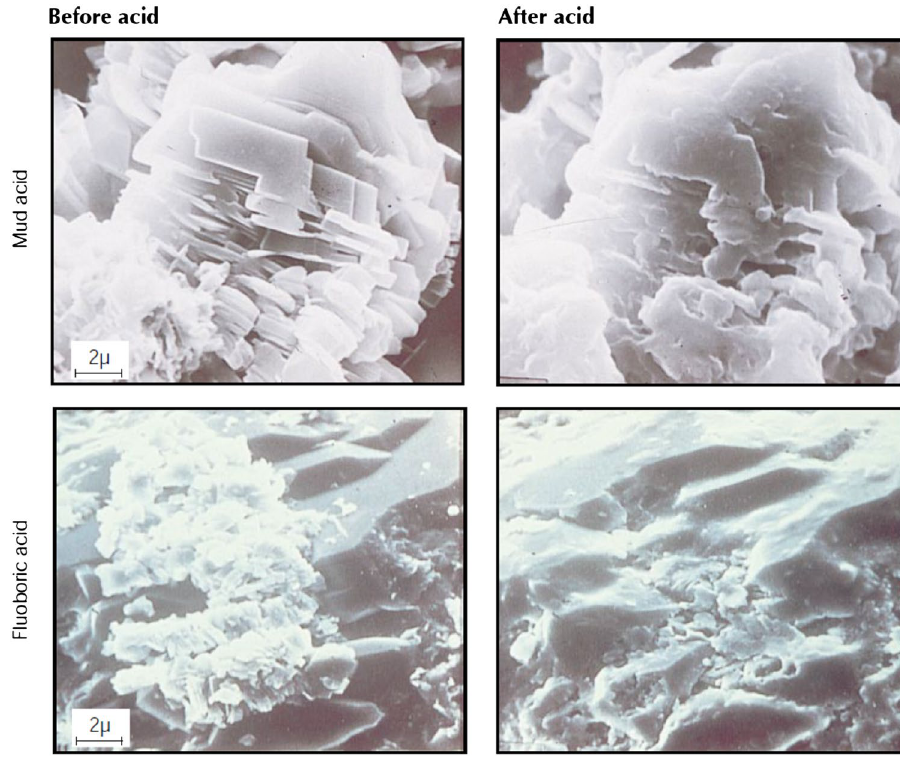
Fig. 9 Comparison of SEM results showing pore filling clay before and after treatment with mud acid and fluoroboric acid (Crowe et al.